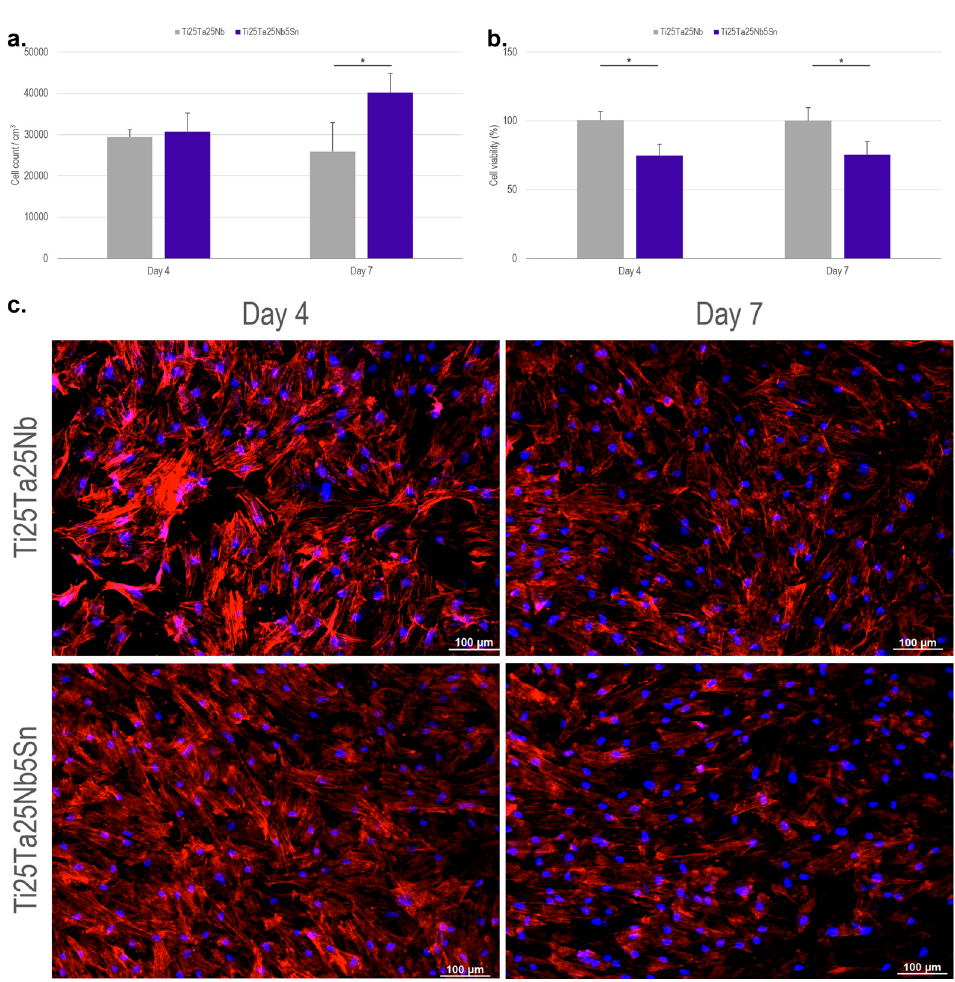
Figure 5. Evaluation of cell adhesion, proliferation, and cell viability on the surface of Ti-25Ta-25Nb and Ti-25Ta-25Nb-5Sn alloys. ( a ) Cell count per area, ( b ) cell viability, and ( c ) fluorescence microscopy images of ADSCs after 4 and 7 days of culture. (*) Represents the significant difference between groups, with p < 0.05.